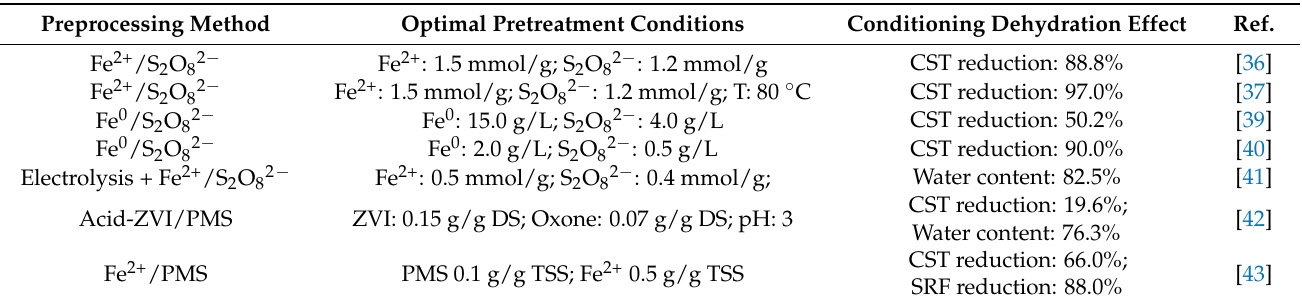
Table 2. Study results of enhanced sludge dewatering by persulfate pretreatment. Preprocessing Method Optimal Pretreatment Conditions Conditioning Dehydration